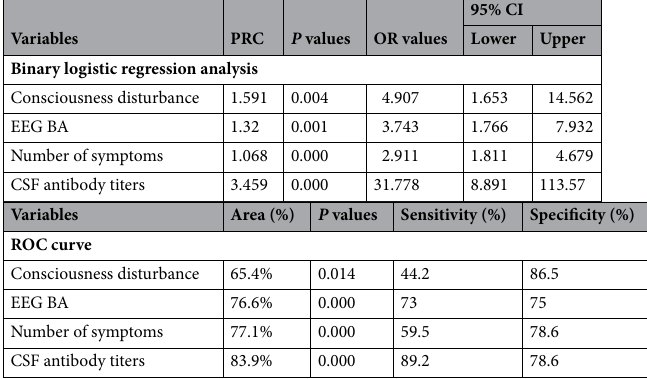
Table 2. Factors associated with prognosis in patients with anti-NMDAR encephalitis. EEG BA EEG background activity during peak stage, PRC partial regression coefficient.